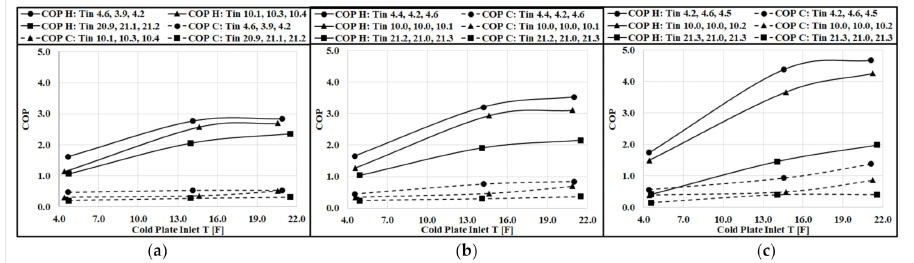
Figure 7. Cold panel inlet water temperature and COPs; ( a ) power demand: 266 W; ( b ) power demand: 120 W; ( c ) power demand: 54 W.